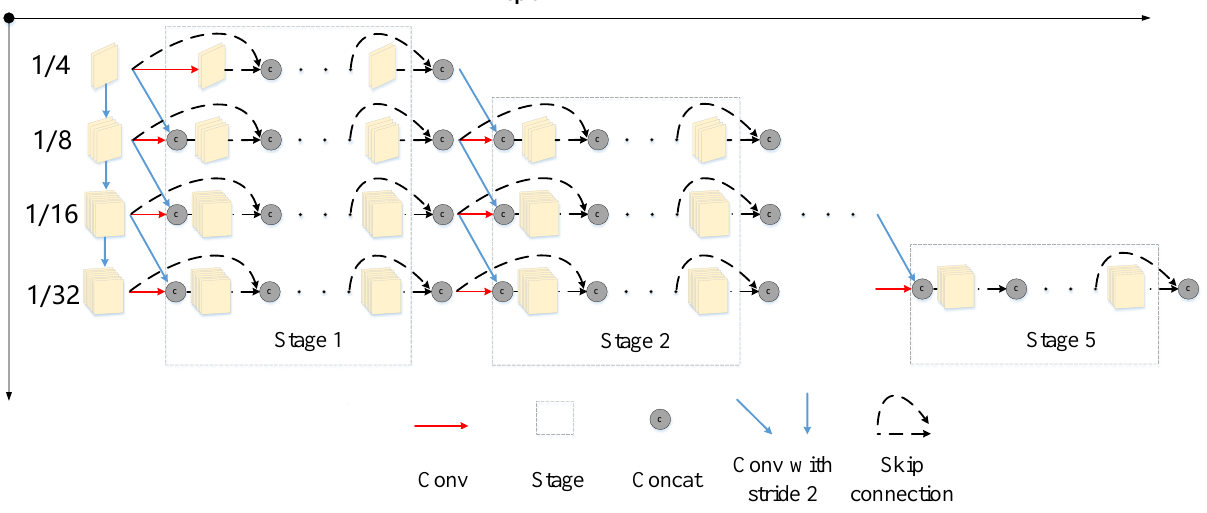
Figure 2. Feature extraction network based on multiscale dense